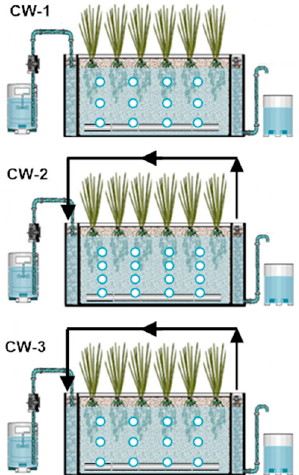
Figure 1. Schematic diagram of the three pilot ‐ scale horizontal subsurface ‐ flow constructed wetlands.